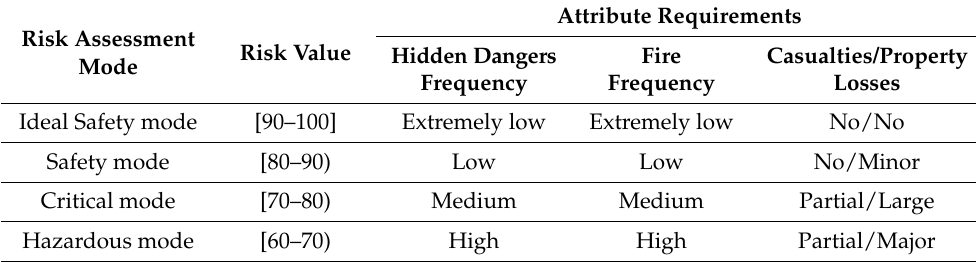
Table 5. Classification of fire risk assessment modes of stadiums.